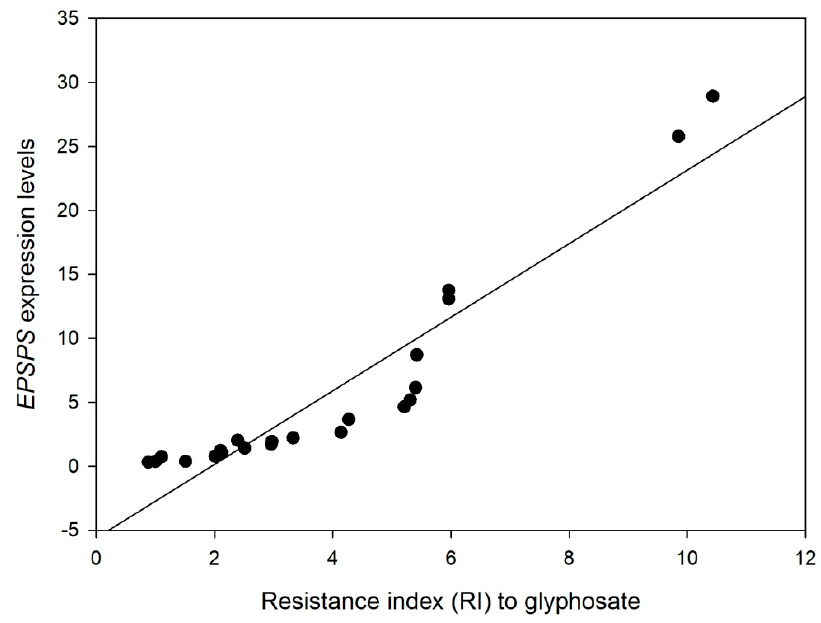
Figure 3. Linear regression analysis between the EPSPS expression level and resistance index (RI) to glyphosate in partial E. indica populations from farmland around Dongting and Poyang lakes, and apple orchards around areas of Bohai Rim and Loess Plateau in China.